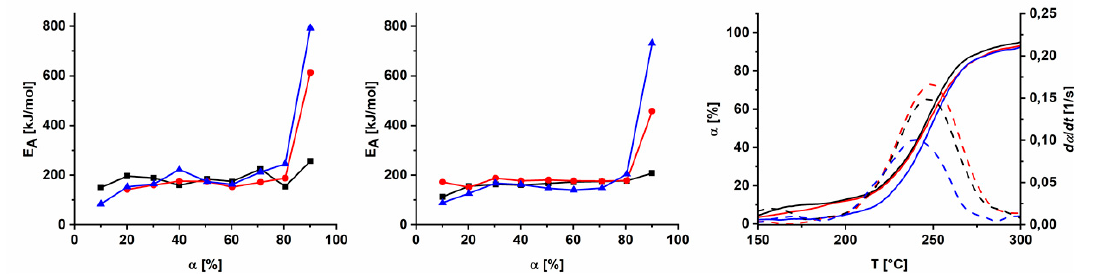
Figure 3. Apparent activation energy E A at different conversion α of AZ-PIM-100 (black), AZ-PIM-R50 (red) and AZ-PIM-A50 (blue) according to Friedman (left) and Kissinger (middle) and for attribution of temperatures, conversion and activation energies a d α /dt-T-plot (right).